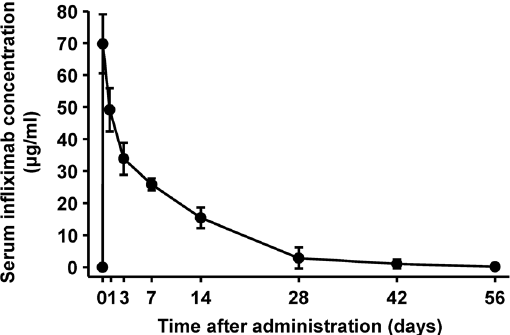
Figure 4. Pharmacokinetics of infliximab. Mean (standard deviation) serum infliximab concentrations after a single dose.